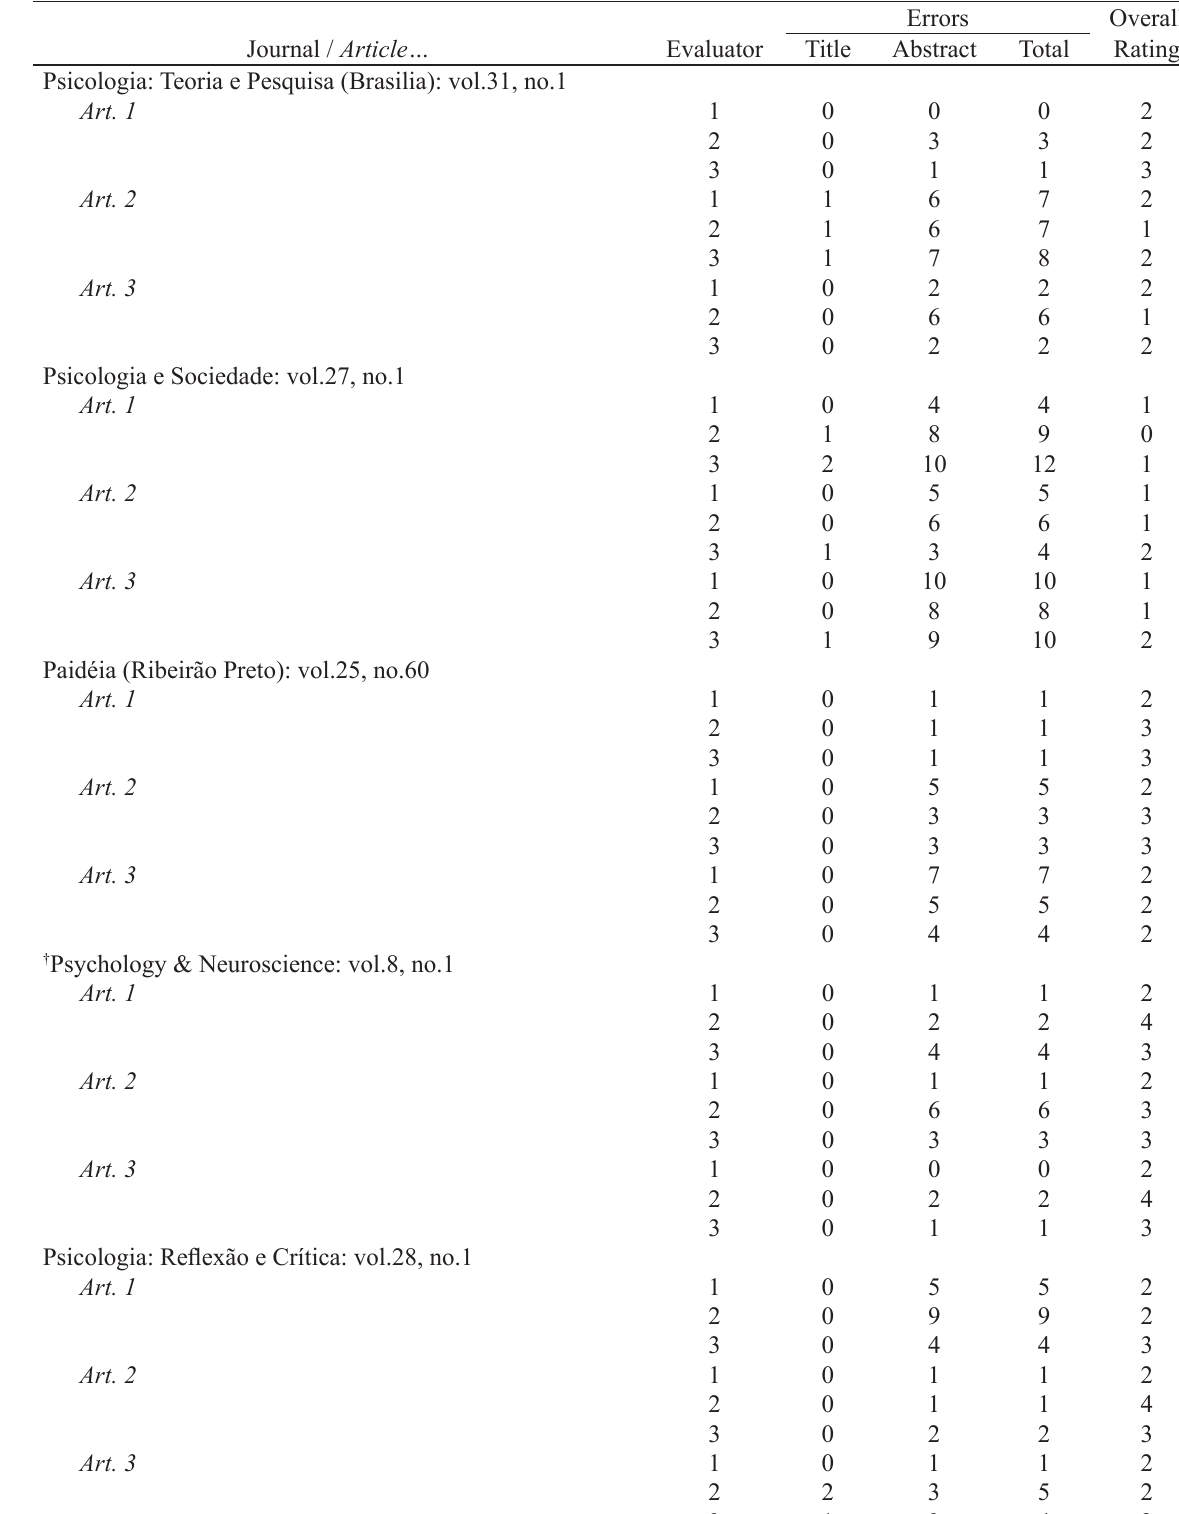
Summary Material Ratings by Native English-Language Scholars: Raw